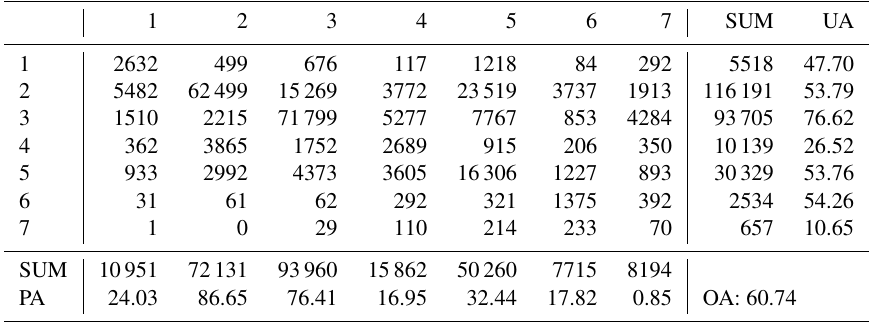
Table B5. Confusion matrix for LANDMATE PFT group 0.5 – the dominant LULC type occupies a minimum of 50% of a LANDMATE PFT grid cell.